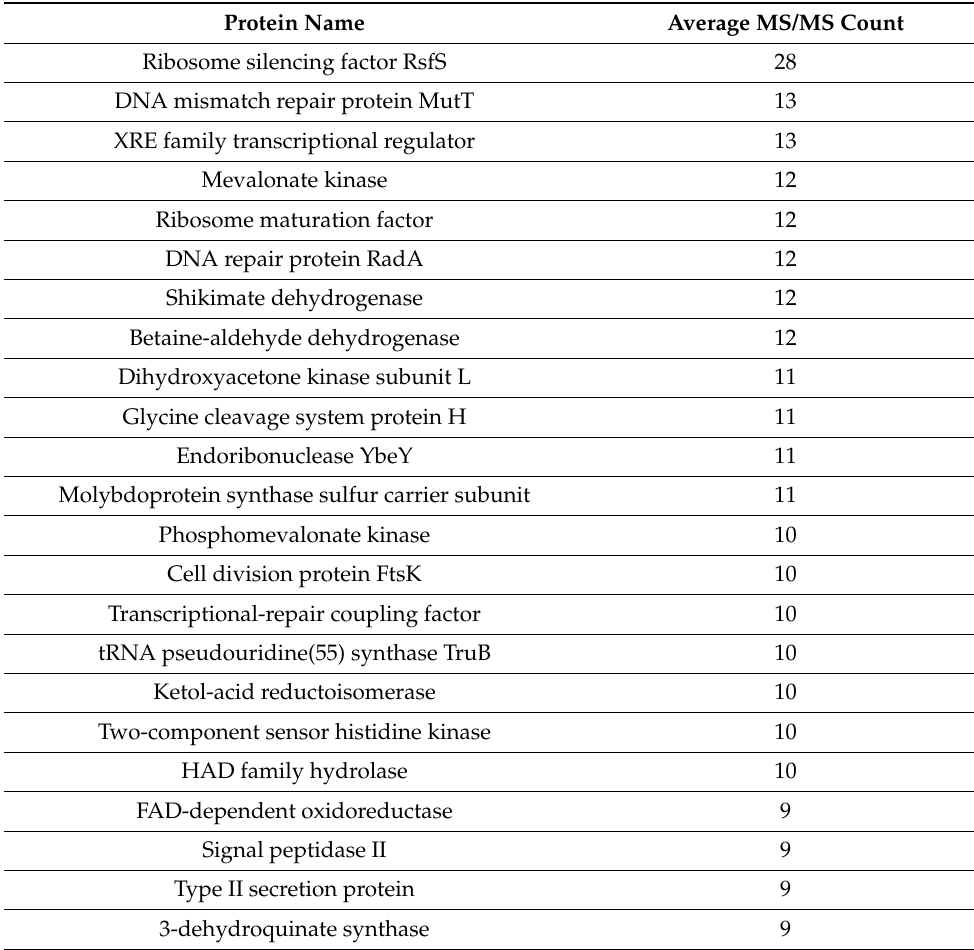
Table 4. Treated group’s unique